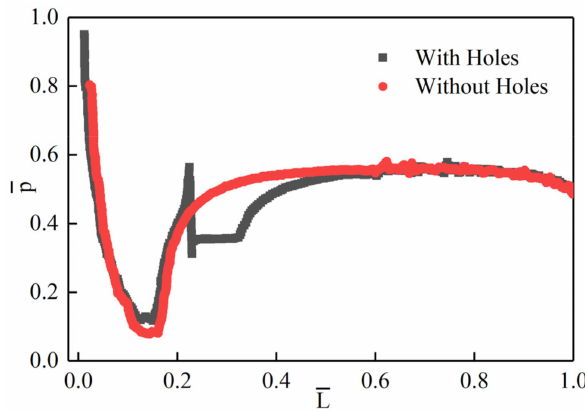
Figure 13. Distribution of surface pressure along